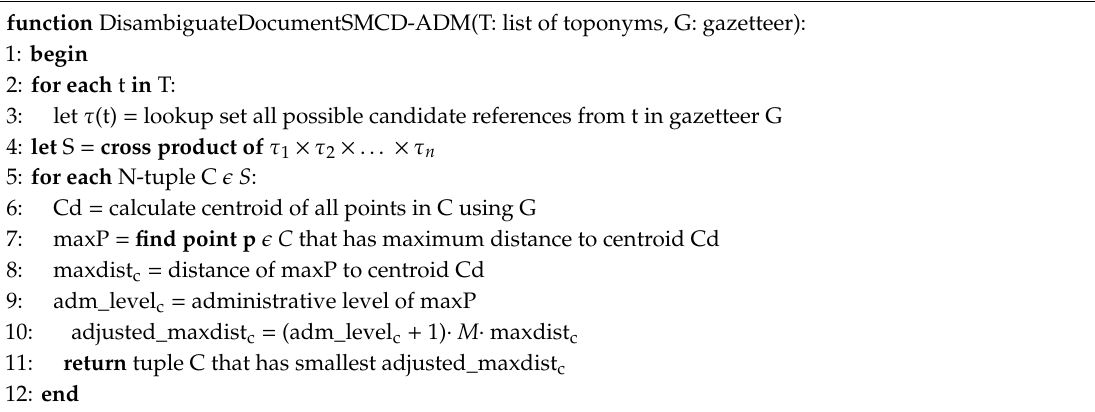
Algorithm 4. Modified Spatial Minimality with Centroid Distance and adjustment factor based on Administrative level and adjustment constant M